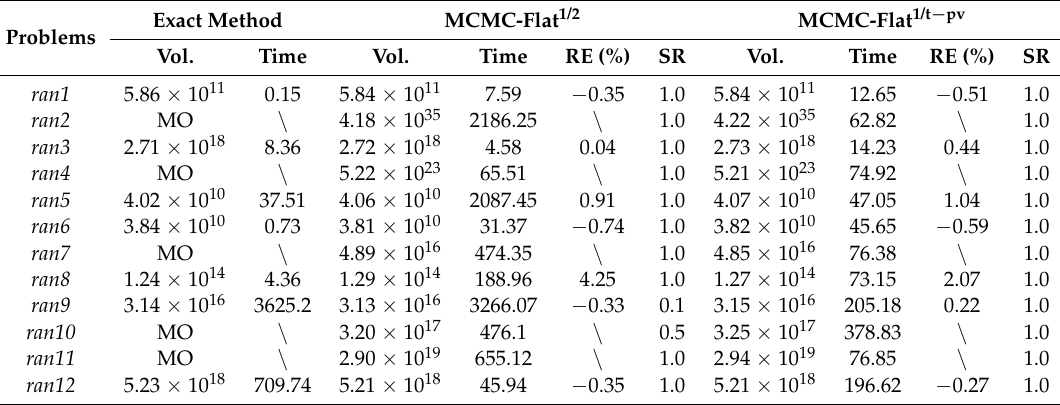
Table 3. Comparison of Exact Method and MCMC-Flat methods on random instances.